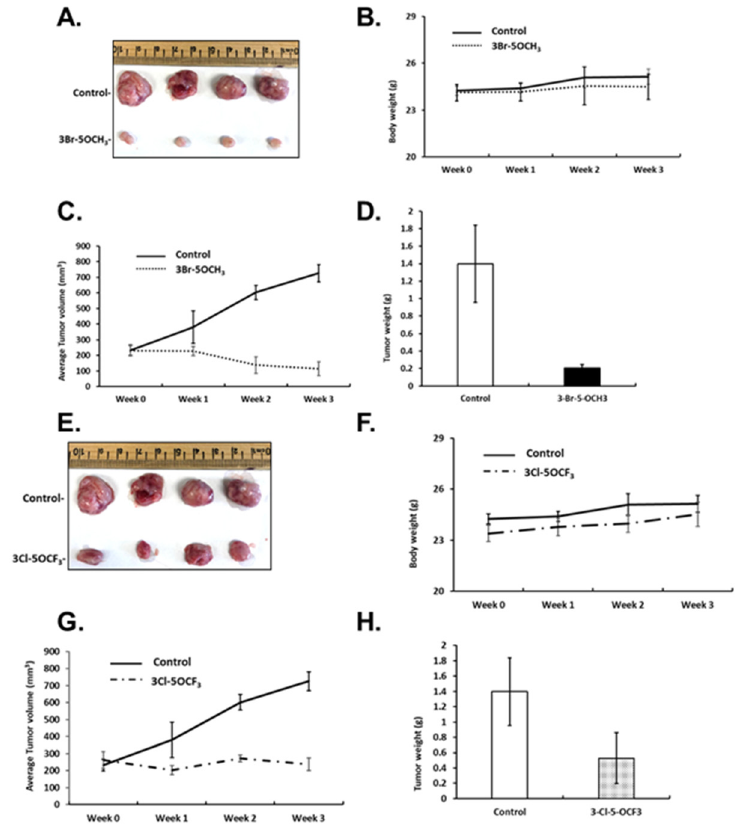
Figure 5 . Inhibition of tumor growth by 3-Br-5-OCH 3 and 3-Cl-5-OCF 3 phenyl-substituted CDIMs. Athymic nude mice were injected with MDA-MB-231 cells orthotopically and administered corn oil or 3-Br-5-OCH 3 (1 mg/kg) daily for 21 days and effects on tumor volume ( A ), body weight ( B ), tumor growth ( C ), and weight ( D ) were determined, as outlined in the Materials and Methods section. The same protocol was used for 3-Cl-5-OCF 3 (1 mg/kg/d) phenyl-substituted CDIM and effects on tumor volume ( E ), body weight ( F ), tumor growth ( G ), and weight ( H ) were determined.